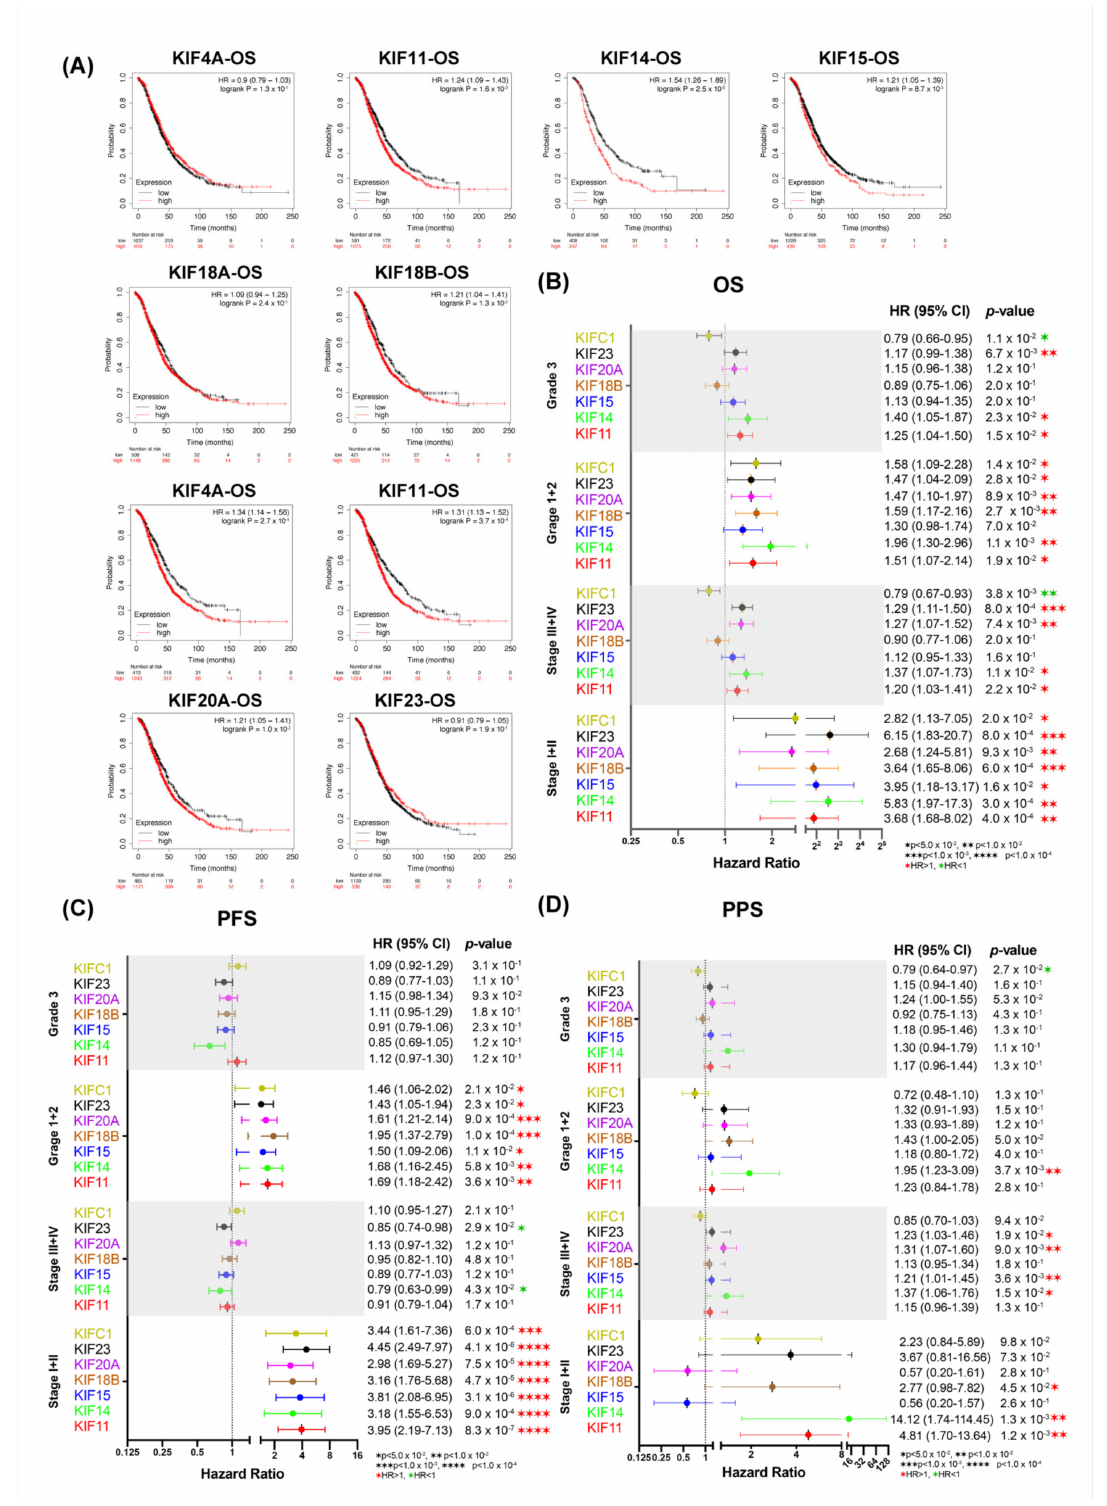
Figure 6. Prognostic values of ten overexpressed mitotic KIFs in OC. ( A ) Survival analyses of ten overexpressed mitotic KIFs regarding OS using TCGA-OV dataset. Red, high-expression group; Black, low-expression group. p -Value is log-ranked. Auto-selected best cutoff is used. Forrest plots of relationship between prognosis ( B ) OS, ( C ) PFS, ( D ) PPS, and ten overexpressed mitotic KIFs mRNA expression in patients with different OC clinicopathological features, including grades and